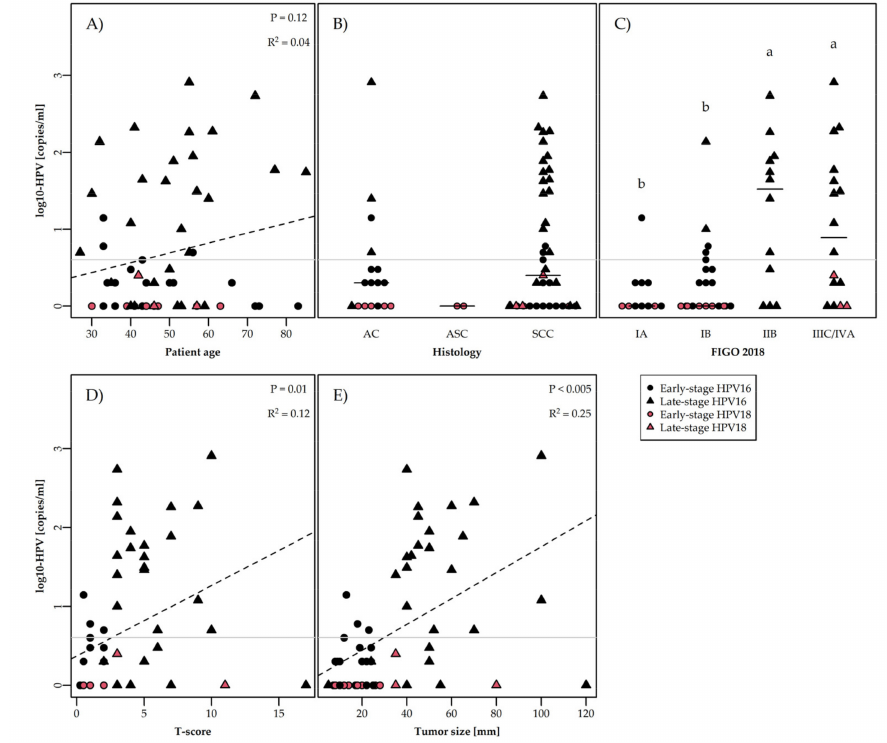
Figure 3. Concentration (copies/mL) of ccfHPV DNA (log scale) detected by ddPCR in cervical cancer patients according to clinical and biological criteria. Statistical significance was tested using the Kruskall–Wallis test followed by Conover–Iman for ( B , C ) and linear regression for ( A , D , E ). Grey line represents cutoff value for ccfHPV DNA positivity (>3 copies/mL). In ( C ), different letters (a,b) denote statistical difference between two groups, whereas the same letters (a, a or b, b) denote no statistical difference between two groups. In ( B , C ), black lines represent median values. ( A ) Concentration by patient age. ( B ) Concentration by histology (AC = adenocarcinomas, ASC = adenosquamous carcinoma, SCC = squamous cell carcinoma). ( C ): Concentration by FIGO 2018 stage (IA = IA1 and IA2, IB = IB1, IB2, and IB3, and IIIC/IVA = IIIC1, IIIC2, and IVA). ( D ) Concentration by tumor score (T score) 1 . ( E ) Concentration by tumor size (mm). T score was evaluated with the TS system